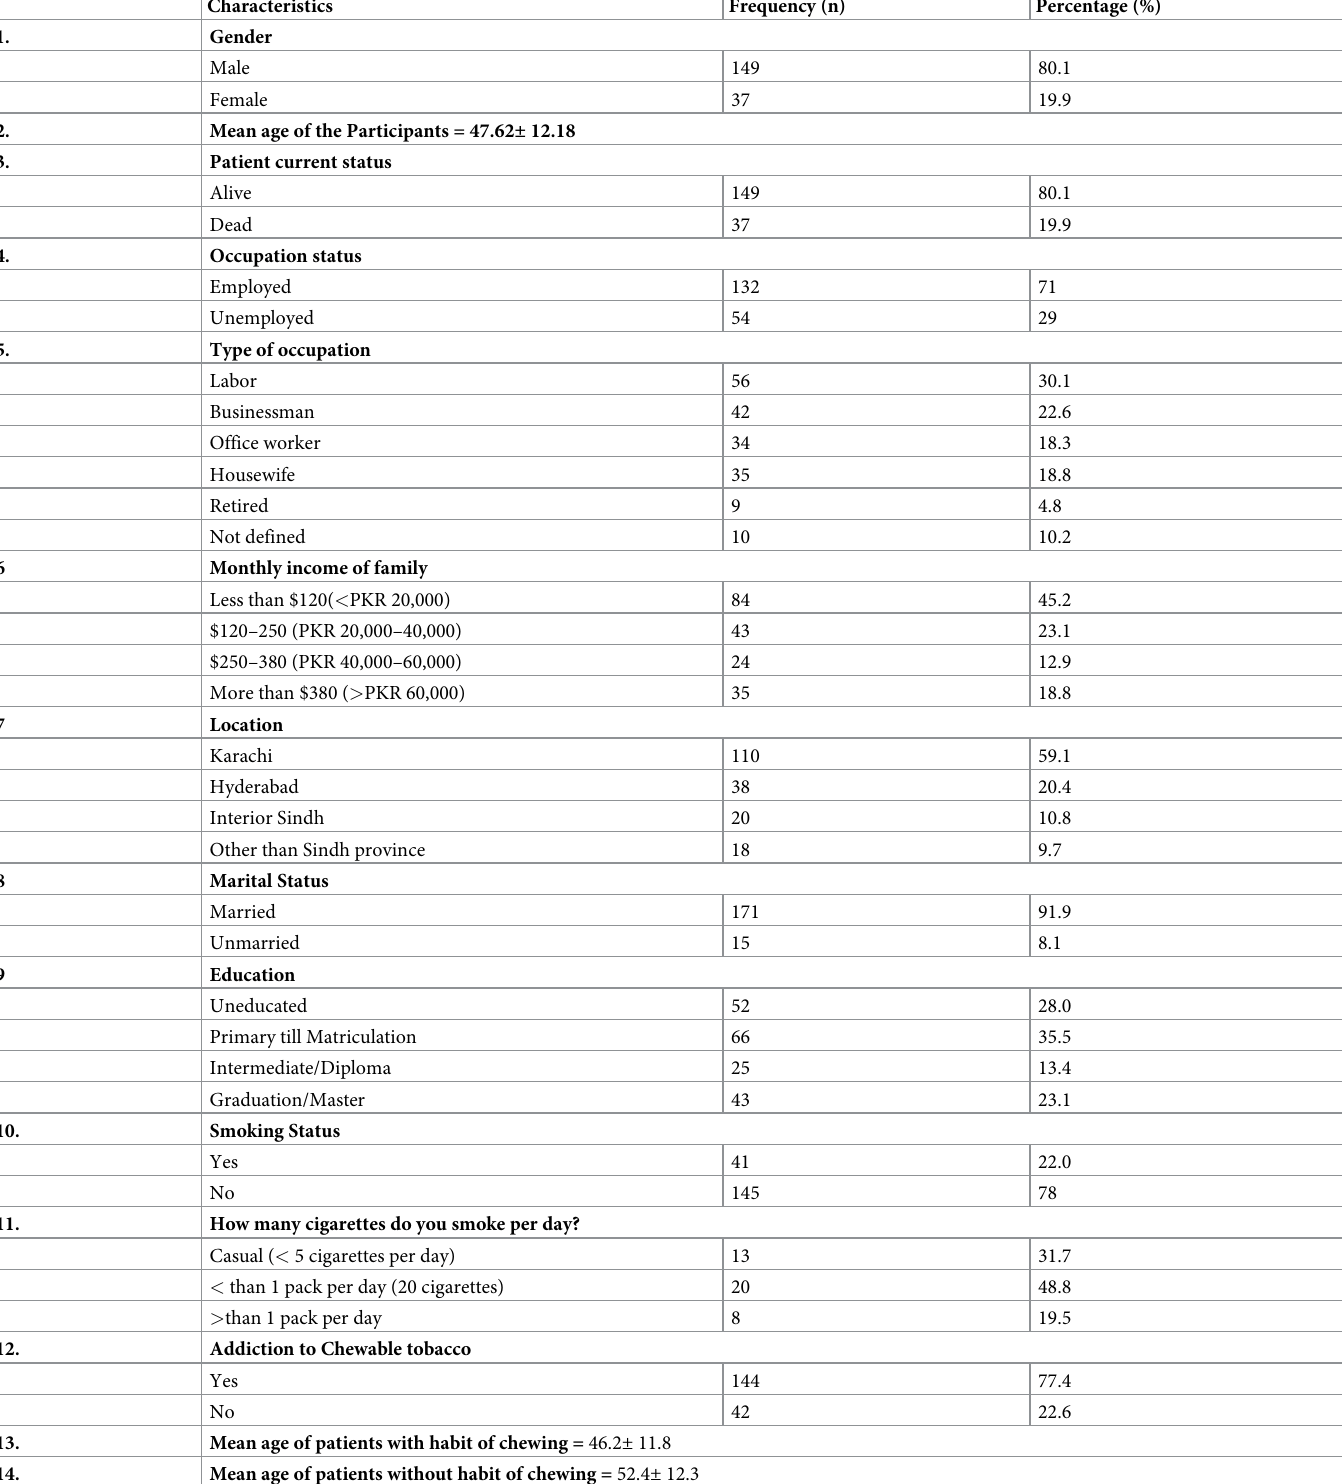
Table 1. Descriptive analysis for demographics and Socioeconomic status (SES) and clinicopathological features of OSCC. N = 186.